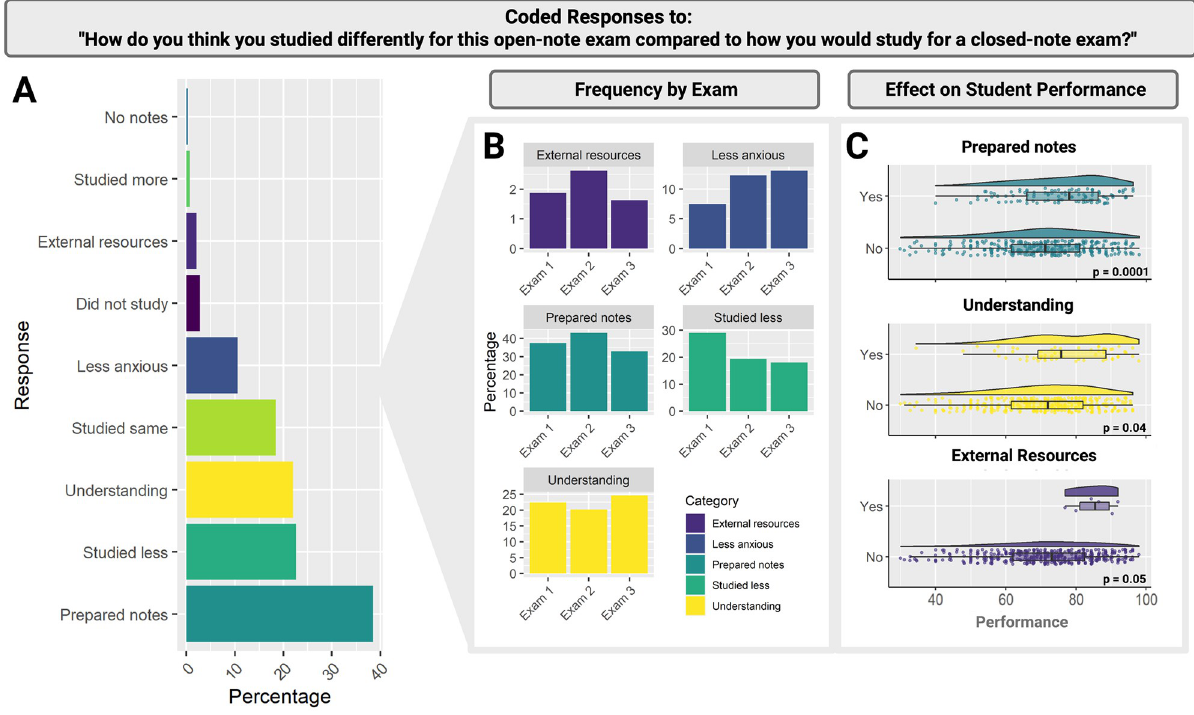
Fig 3. Adapting study habits to open-note format. Students were asked to respond to the following prompt: “ How do you think you studied differently for this open-note exam compared to how you would study for a closed-note exam ? ” (A) Student responses are ordered by frequency of student reporting. (B) Longitudinal plotting of student responses indicate student approaches to open-note exams may vary over time in terms of students’ use of “External Resources”, feeling “Less Anxious”, having “Prepared Notes,” having “Studied Less” and focus on “Understanding”. (C) Student performance increased in response to study habit adaptations that include having “Prepared Notes,” an increased focus on “Understanding,” and the use of “External